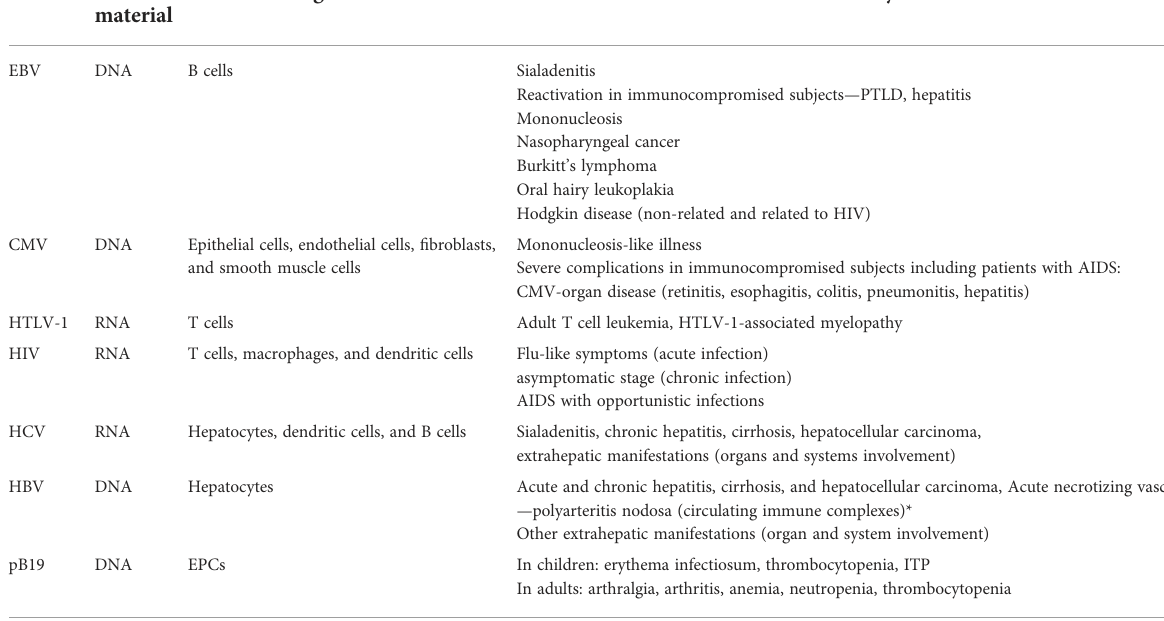
TABLE 3 Main viruses involved in the pathogenesis of pSS.